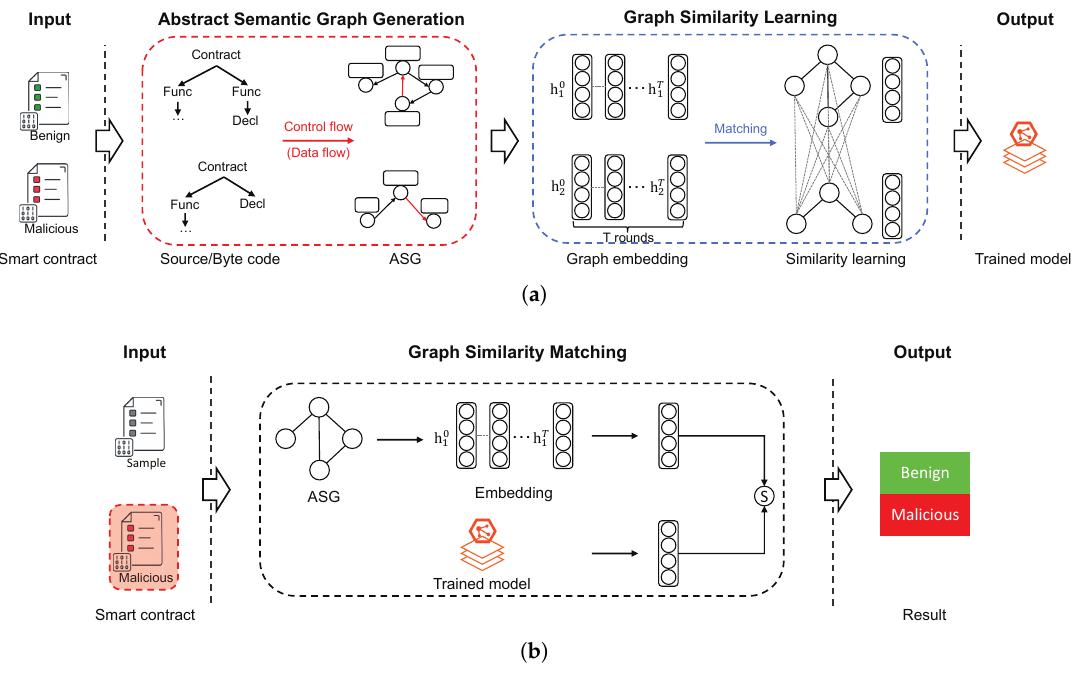
Figure 3. The general framework of our proposed approaches. ( a ) Model training ( b ) Vulnerabil- ity